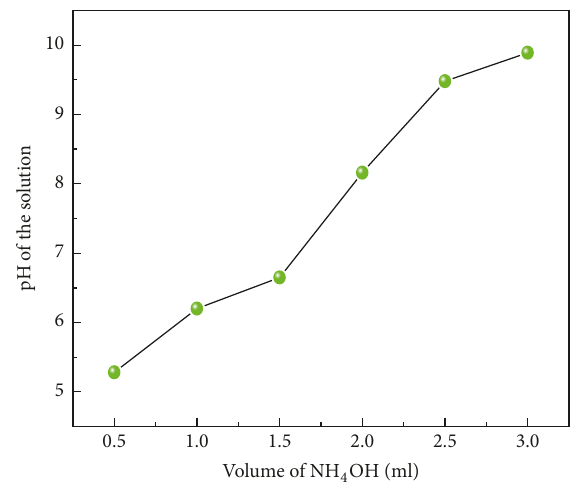
Figure 2: The plot of pH versus NH 4 OH concentration.